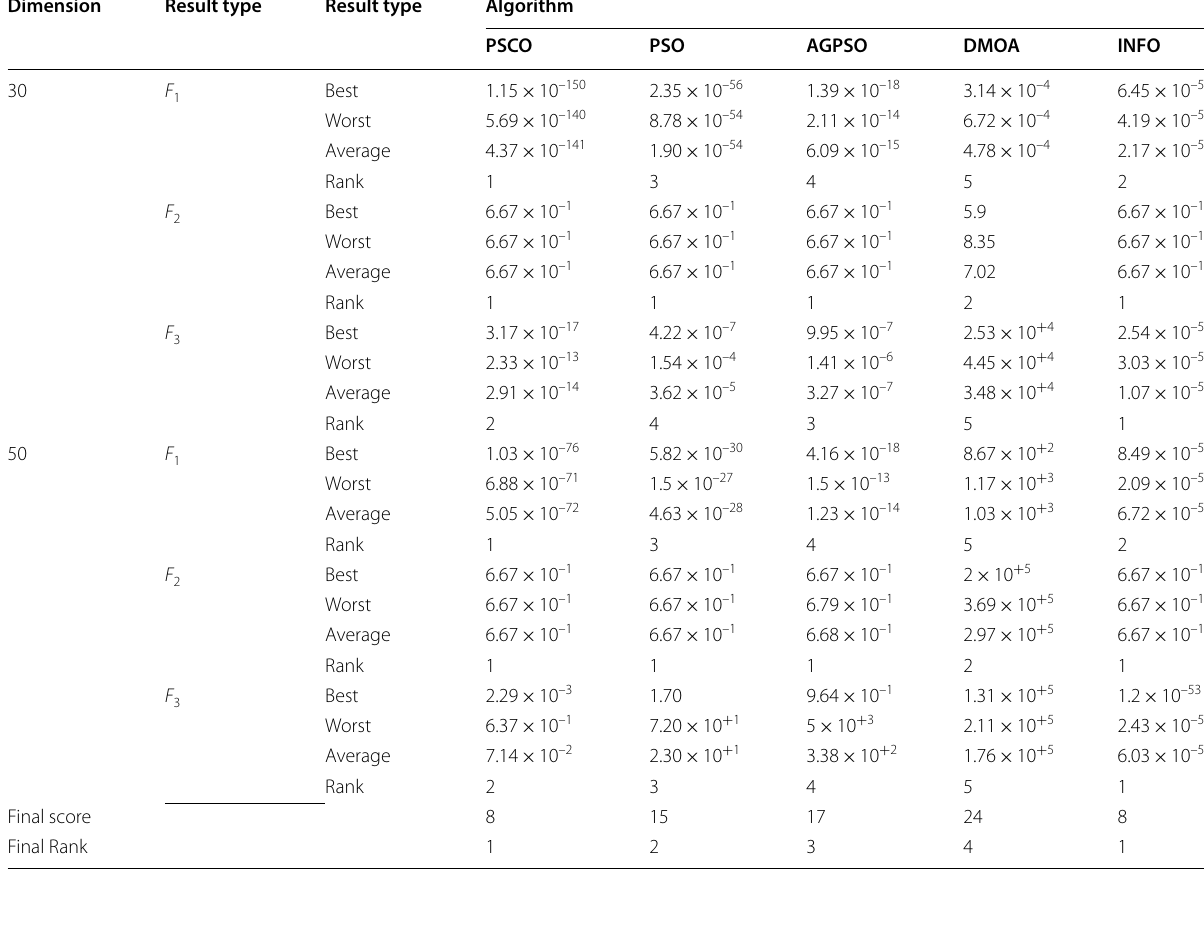
Table 4 Results obtained by the application of unimodal functions Dimension Result type Result